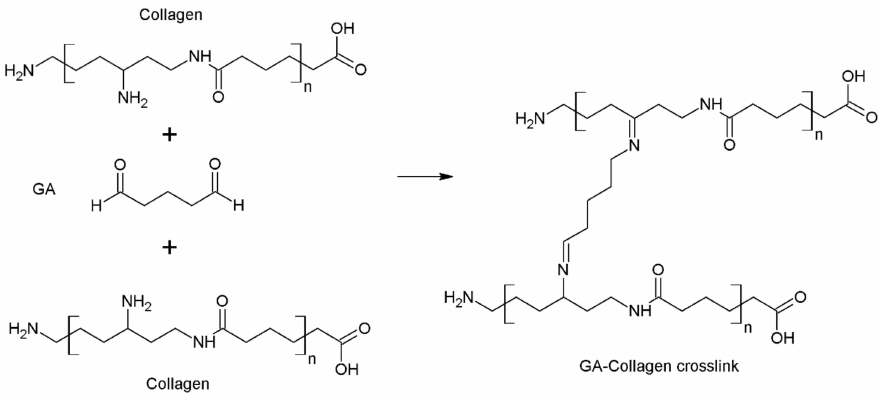
Figure 5. Collagen cross-linking reaction using glutaraldehyde